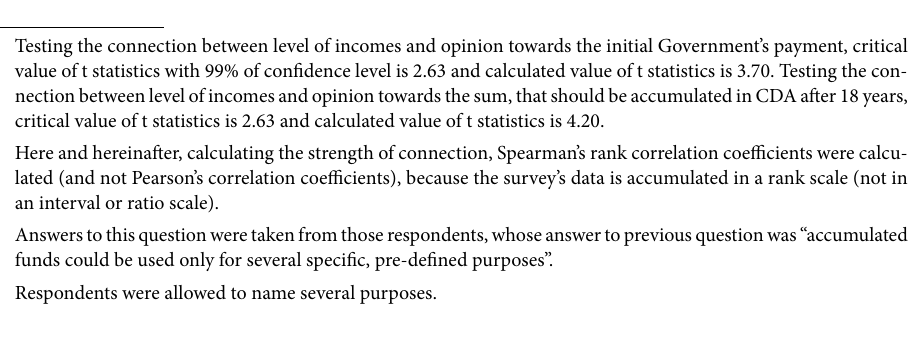
Fig. 9. Respondents’ opinion towards the usage of funds, accumulated in CDA (authorial computation, according to the survey data)